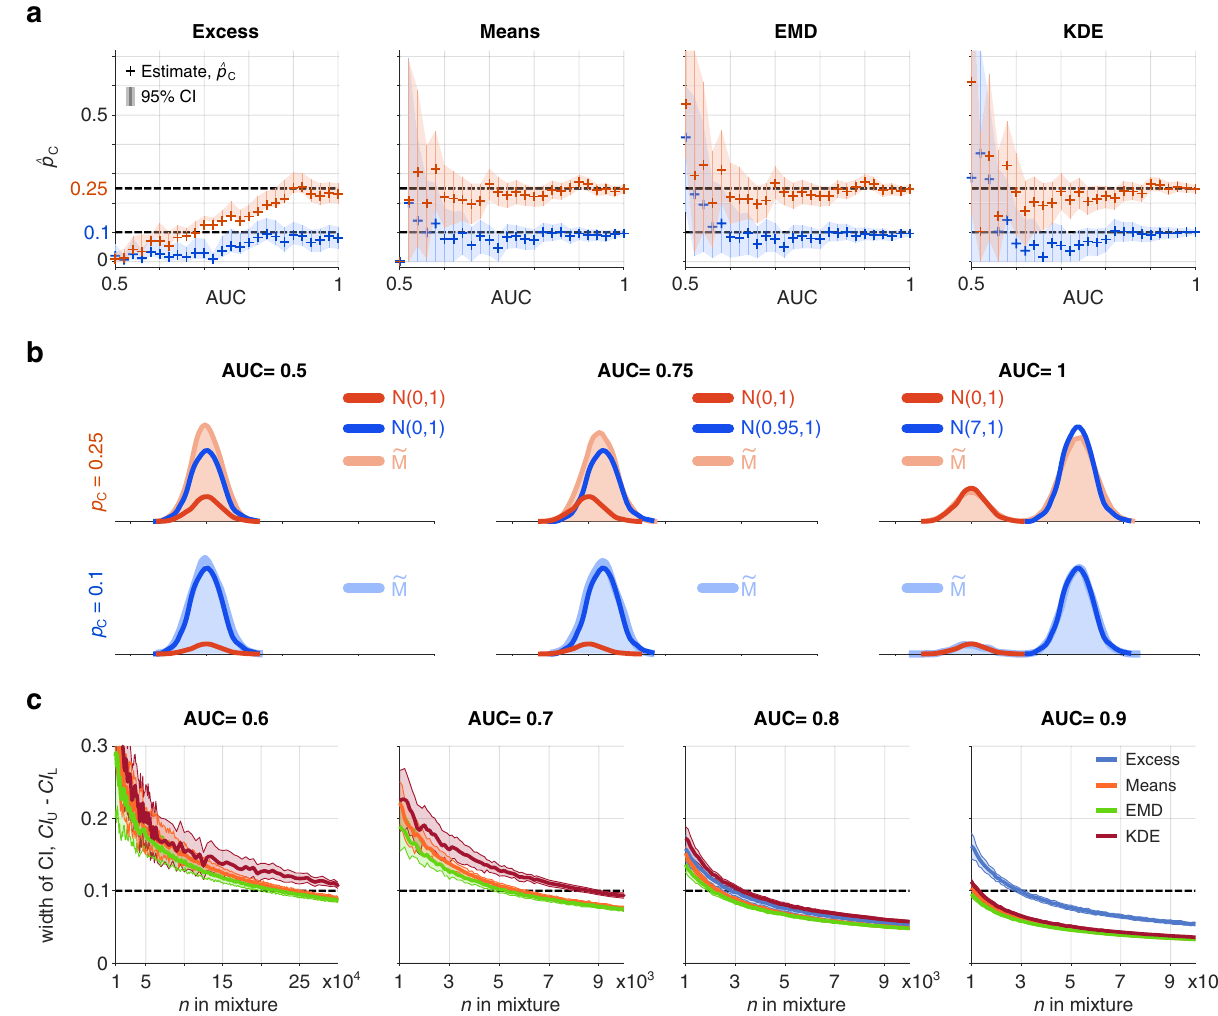
Fig. 4 A comparison of the four methods using an arti fi cial genetic risk score with increasing discriminative ability as measured by AUC, from AUC = 0.5 (no discriminative ability) through to AUC = 1, (complete differentiation). a The estimated proportion ( + marker) with con fi dence intervals (vertical lines with shading) around p C ¼ 0 : 1 (blue) or p C ¼ 0 : 25 (red) for each of the methods (Excess, Means, EMD, KDE) are shown using mixture size, n ¼ 5 ; 000. b The constructed mixture distributions and reference distributions (R , shaded red and R , shaded blue) from which they were constructed C N for AUC = {0.5, 0.75, 1}. c Dependence of the width of CI ( CI U (cid:2) CI L ) on the number of points in the mixture sample for AUC = {0.6, 0.7, 0.8, 0.9} and p ¼ 0 : 1. Curves and shading show median± standard deviation of the width of CI. The plot for the Excess method for AUC = {0.6, 0.7} is omitted C because the method does not converge to p C ¼ 0 : 1. This fi gure is generated using arti fi cial data: N( μ , σ ) is a normal distribution with mean μ = {0.0, 0.08, 0.15, 0.22, 0.29, 0.37, 0.44, 0.51, 0.59, 0.66, 0.74, 0.82, 0.91, 0.99, 1.09, 1.19, 1.29, 1.4, 1.52, 1.65, 1.81. 1.98, 2.19, 2.47, 2.91, 7} and standard deviation σ =